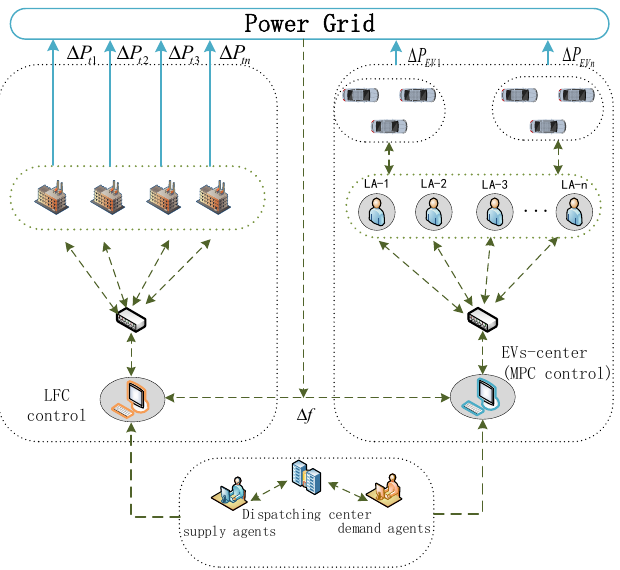
Figure 1. Frequency regulation frame for electric vehicles based on MPC.